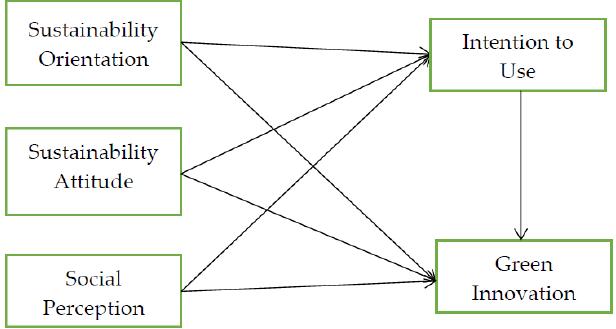
Figure 1. The framework of the study.